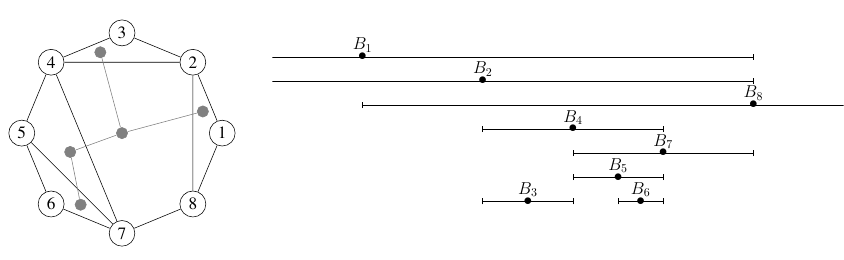
Fig. 5: The dissections of a convex polygon outerplanar graph with its weak dual (left hand size) and a construction of its c - p -B OX (1) -realization according to Theorem 5.